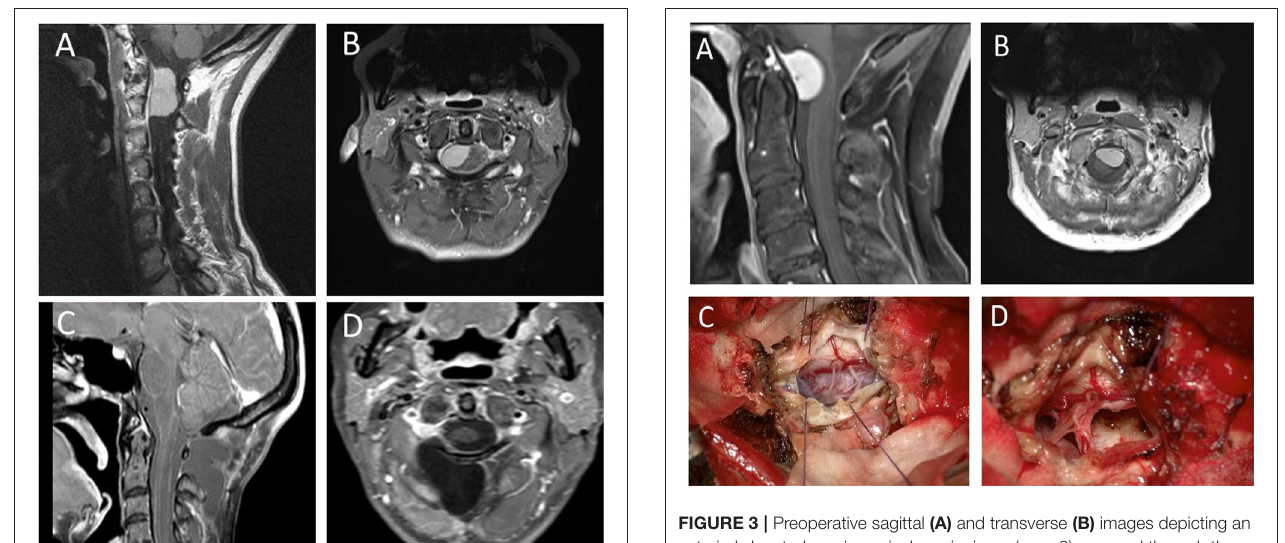
FIGURE 3 | Preoperative sagittal (A) and transverse (B) images depicting an anteriorly located craniocervical meningioma (case 2) removed through the atlantooccipital space. After dura tuck-up sutures the microsurgical view shows a nicely exposed tumor surface (C) without any removal of boney structures. The vascular tumor base was bipolar coagulated and resected in total so that finally a Simpson ◦ II resection was achieved (D)